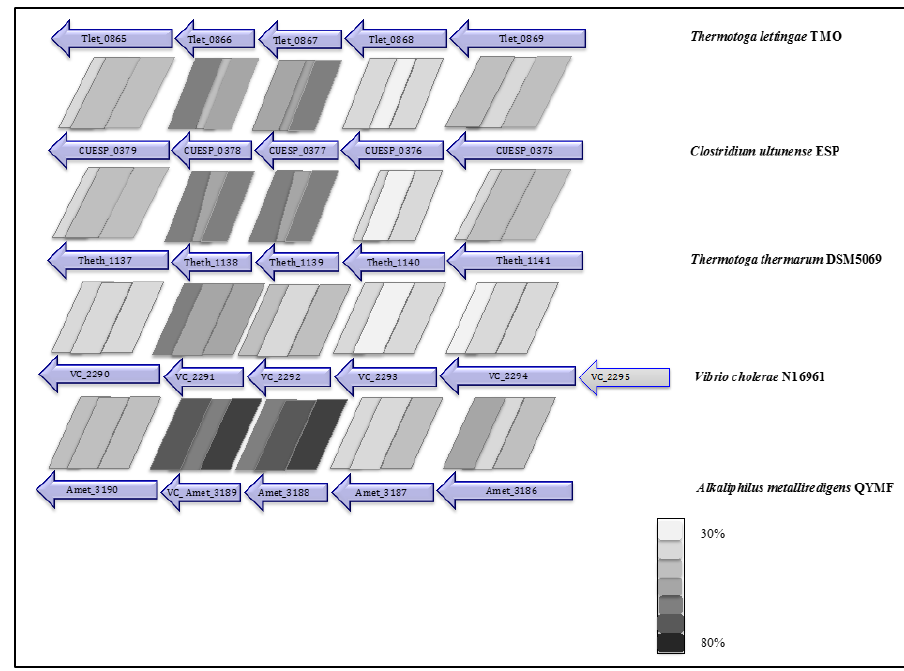
Figure 3. Organisation of the Nqr genes in C. ultunense , P. lettingae , Pseudothermotoga thermarum , Vibrio cholera , and Alkaliphilus metalliredigens